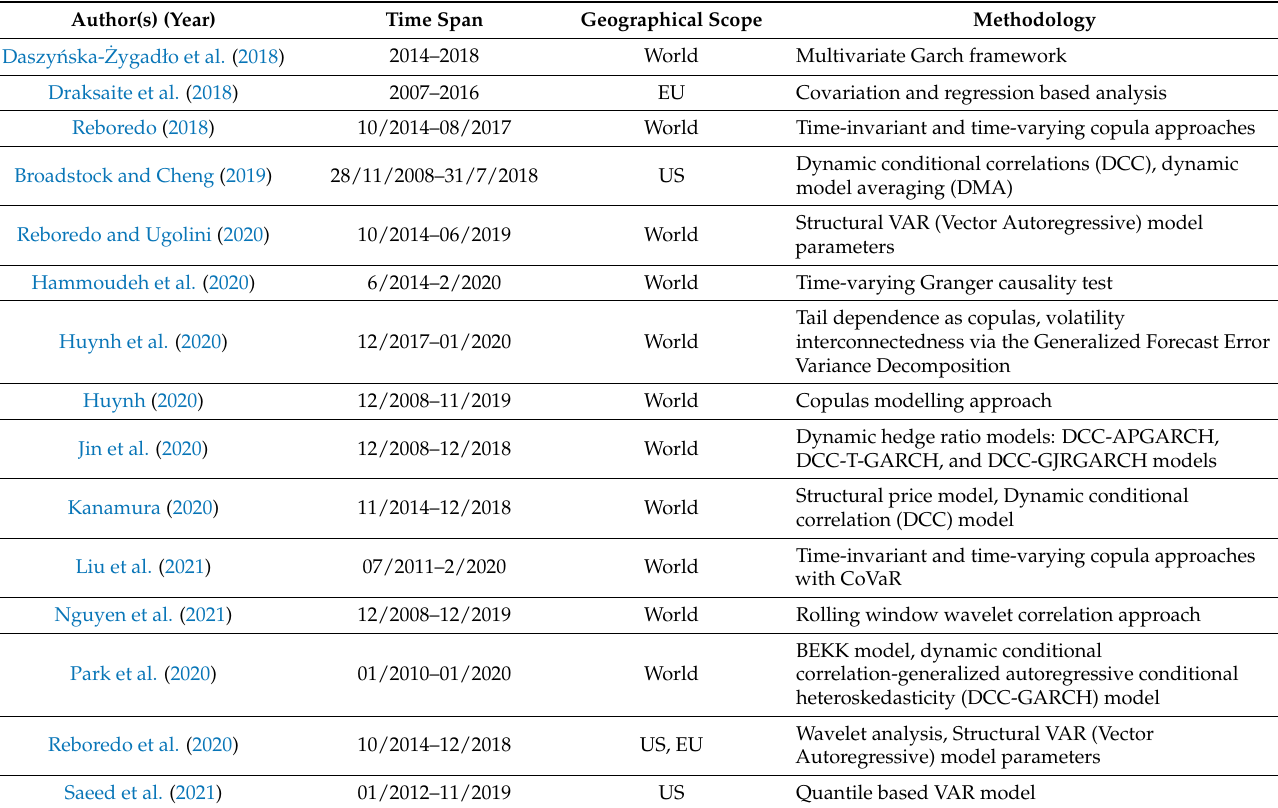
Table 6. “Green bond connectedness w/other financial instruments” empirical literature by type of sample and methodology. Author(s) (Year) Time Span Geographical Scope Methodology